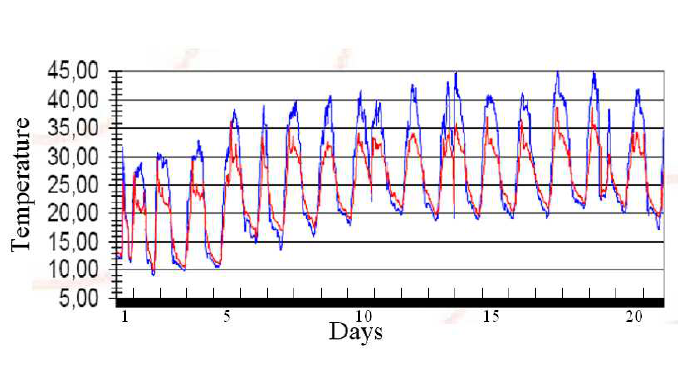
Figure 3. Screenshot of temperature behavior measured during June 2006 by 2 different nodes (red and blue curves, respectively).